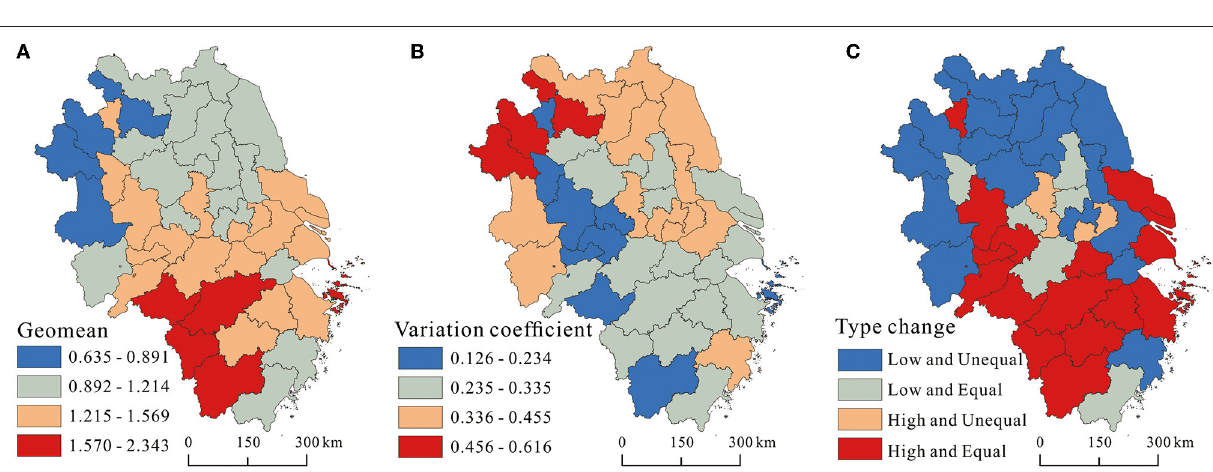
FIGURE 2 | The variation and Gini coefficients of the supply level of healthcare service.